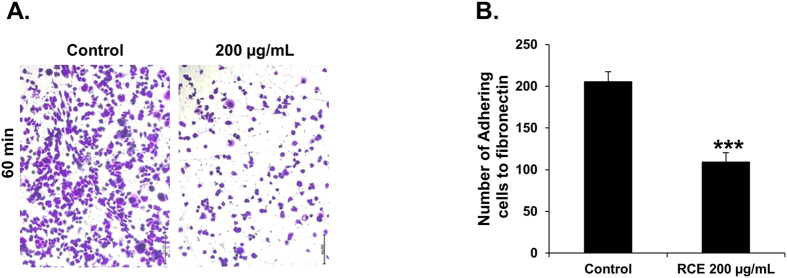
Rhus coriaria inhibits adhesion of MDA-MB-231 cells to fibronectin.(A) Effects of RCE on MDA-MB-231 cell adhesion to fibronectin-coated wells. MDA-MB-231 cells were seeded on the fibronectin-coated wells with or without RCE. After 60 min of incubation, non-adhered cells were washed. Attached cells were stained with crystal violet and photographed with an inverted microscope at X100 magnification (Nikon Ti-U, Nikon). (B) Quantification of attached MDA-MB-231 cells to fibronectin. The number of adherent MDA-MB-231 cells to fibronectin was determined by counting at least 5 random fields per well at X200 magnification with an inverted microscope (Nikon Ti-U, Nikon). Data represent a mean of cells counted per field and are representative of three independent experiments. Statistical analysis was performed using one-way ANOVA (***p < 0.001).